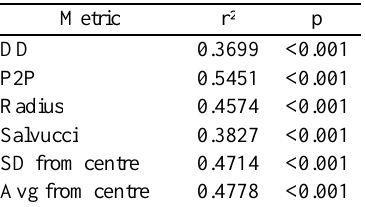
Figure 10: Minimum Levenshtein difference against average point-to-point distance within fixations per participant after application of the Radius metric for fixation identification Table 2. Significance of linear regressions of minimum Levenshtein difference against average point-to-point distance per participant for each of the metrics